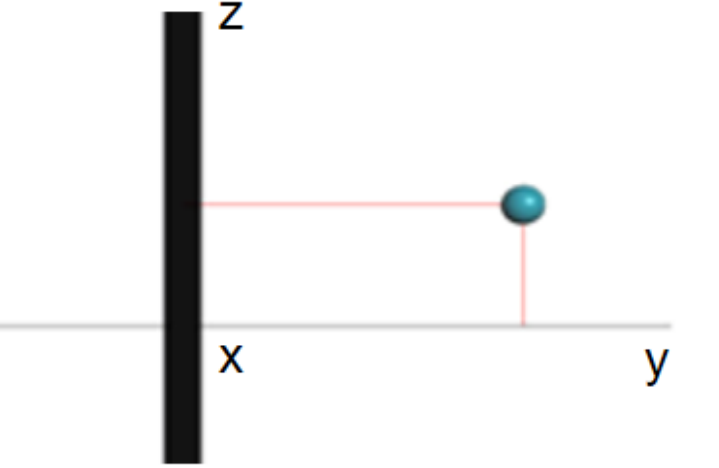
Figure 11. Interface elements of the “plane charge” visuo-haptic environment developed with Chai